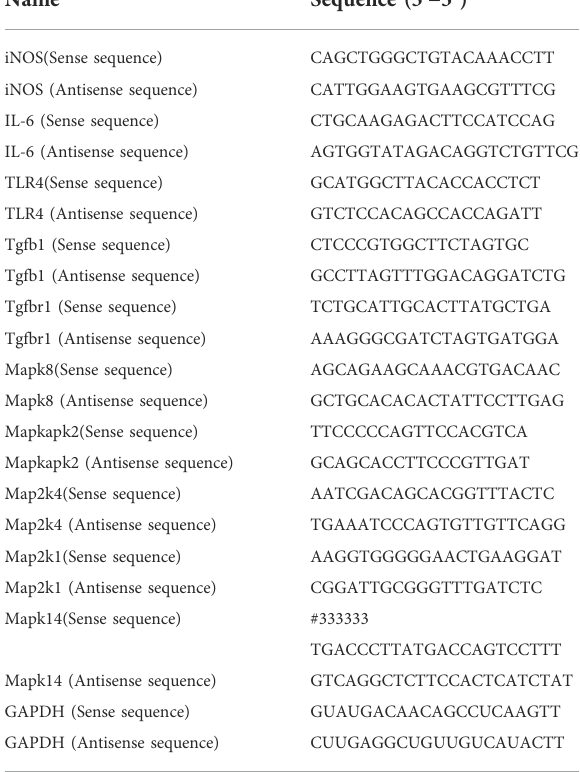
TABLE 1 Primer sequences for RT-qPCR.